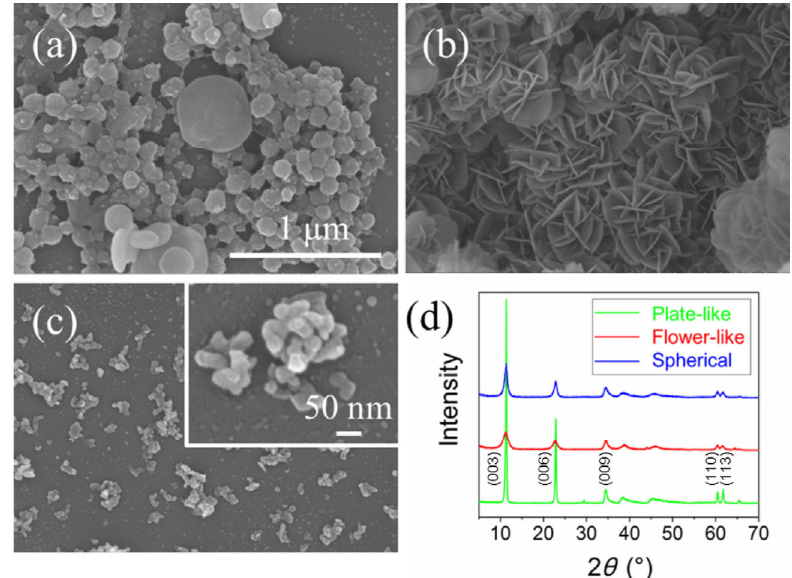
Fig. 3 SEM images of MgAl–LDHs with (a) plate-like, (b) flower-like, and (c) spherical morphology; (d) XRD patterns of these